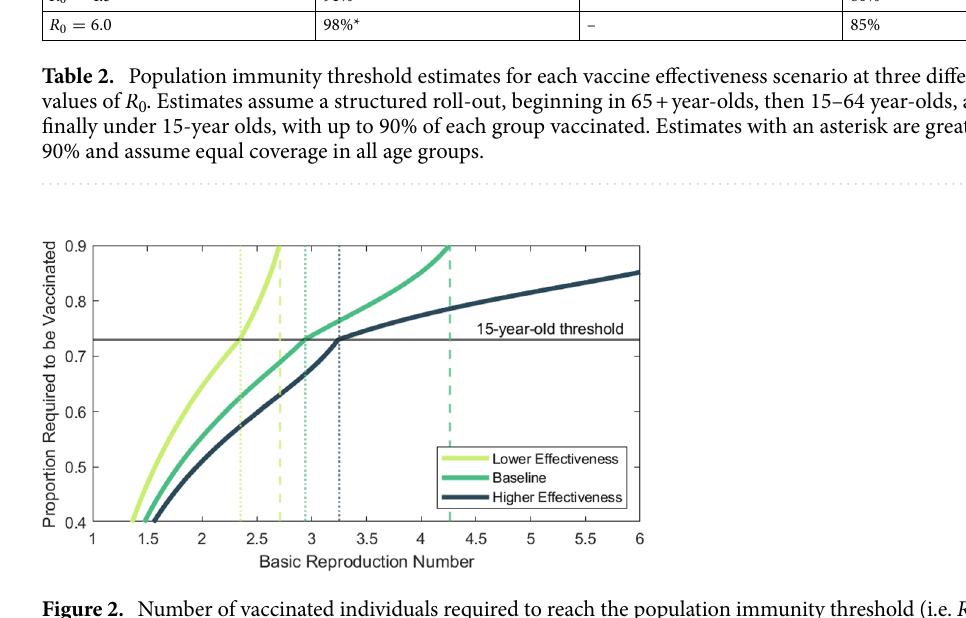
Figure 2. Number of vaccinated individuals required to reach the population immunity threshold (i.e. R v = 1 ) for varying values of R 0 under the same age-prioritised roll-out sequence and maximum 90% coverage as in this figure. Points above the thin horizontal line require vaccination of under 15-year-olds. Vertical dotted lines indicate the largest value of R 0 for which the population immunity threshold can be reached with 90% coverage of over 15-year-olds. Vertical dashed lines indicate the largest value of R 0 for which the population immunity threshold can be reached with 90% coverage of the total